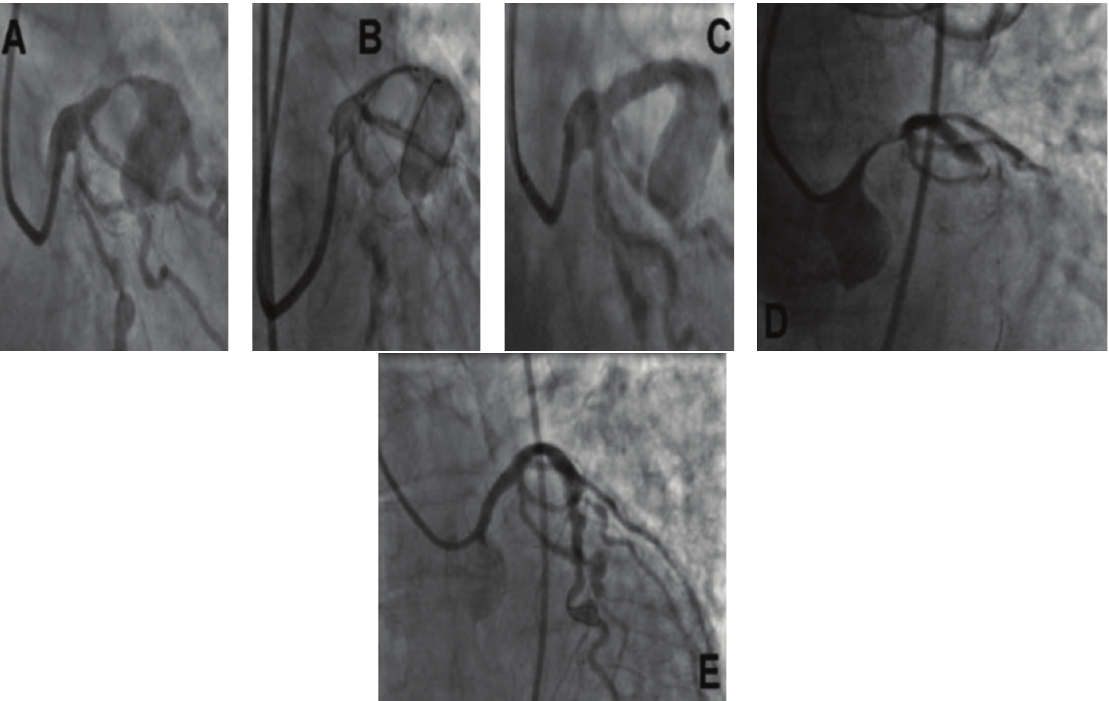
Figure 1: Angiographic projections in (A) (23 ◦ RAO and 21 ◦ CAU): giant, calcified, aneurism of proximal LAD, and coronary subocclusion immediately proximal to the sac; (B) (21 ◦ RAO and 7 ◦ CAU): PCI with stent placement in LAD; (C) (21 ◦ RAO and 15 ◦ CAU): angiographic result after stenting of LAD; (D) (3 ◦ LAO and 1 ◦ CRA): subocclusion of the left main coronary artery (LMCA) with patency of the bare metal stent previously implanted in the proximal tract of the LAD and closure of the coronary aneurism; (E) (17 ◦ LAO and 4 ◦ CAU): angiographic result after primary PCI. LAO: left anterior oblique; RAO: right anterior oblique; CRA: cranial; CAU: caudal.